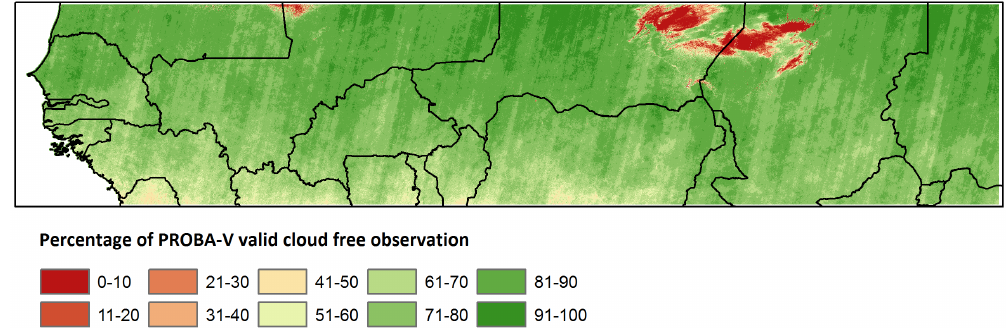
Figure 4. Percentage of PROBA-V valid cloud-free observation for the study area during the whole time series. False detection of clouds is systematically observed over the desert area. The valid cloud-free observation percentage decreases with latitude.